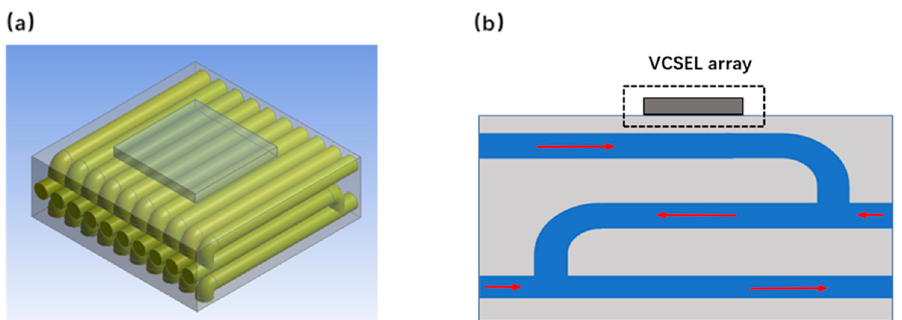
Figure 2. ( a ) Model of the double-layer reflow microchannel heat dissipation system. ( b ) Schematic diagram of the side-view cross-sectional structure of the double-layer reflow microchannel.